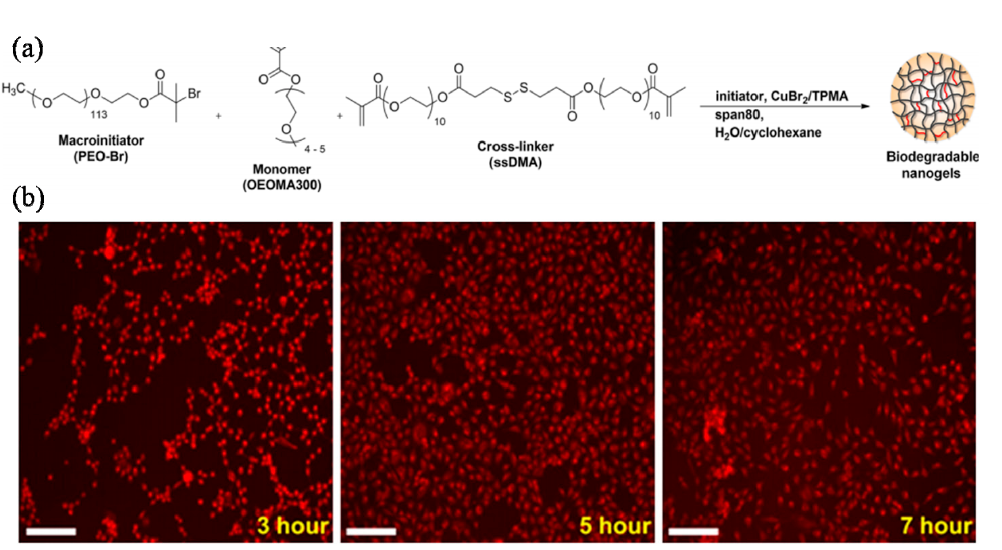
Figure 8. ( a ) Scheme for biodegradable nanogels synthesized by inverse miniemulsion ATRP; ( b ) Fluorescent images of cells with Ce6-loaded nanogels as a function of incubation time (scale bar 300 µm). Copyright 2016, Springer.